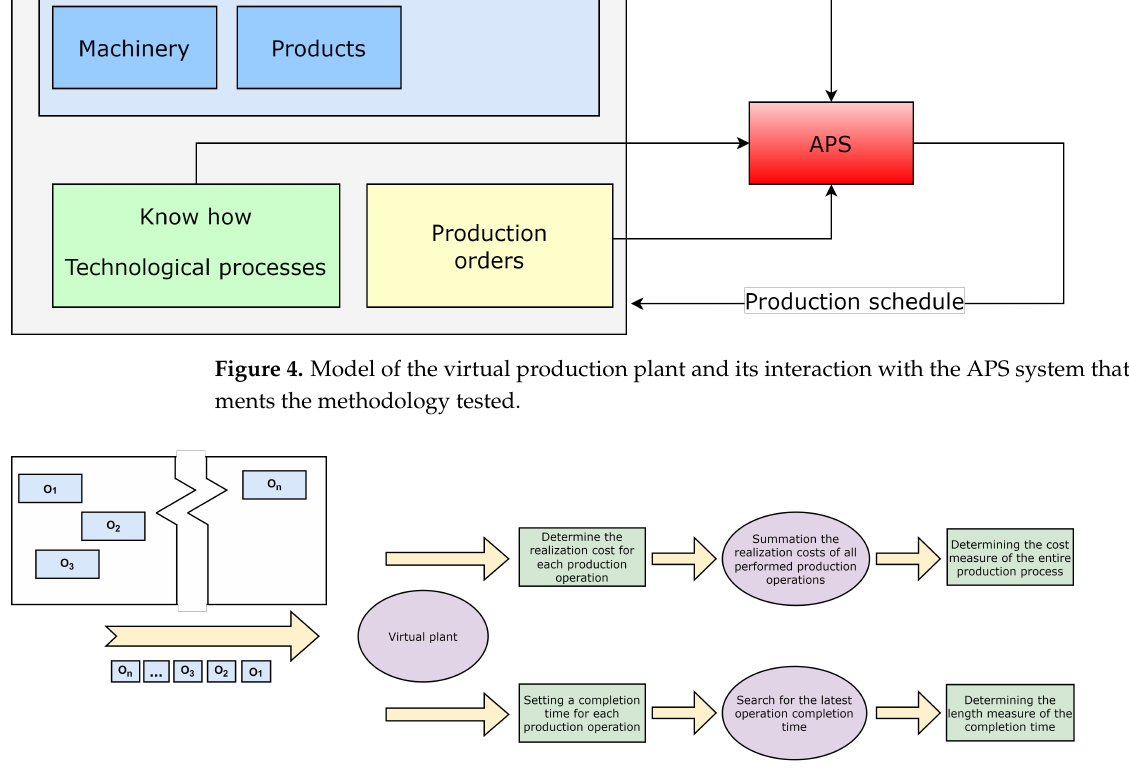
Figure 5. Scheme of simulating the implementation of the delivered production schedule in a virtual production